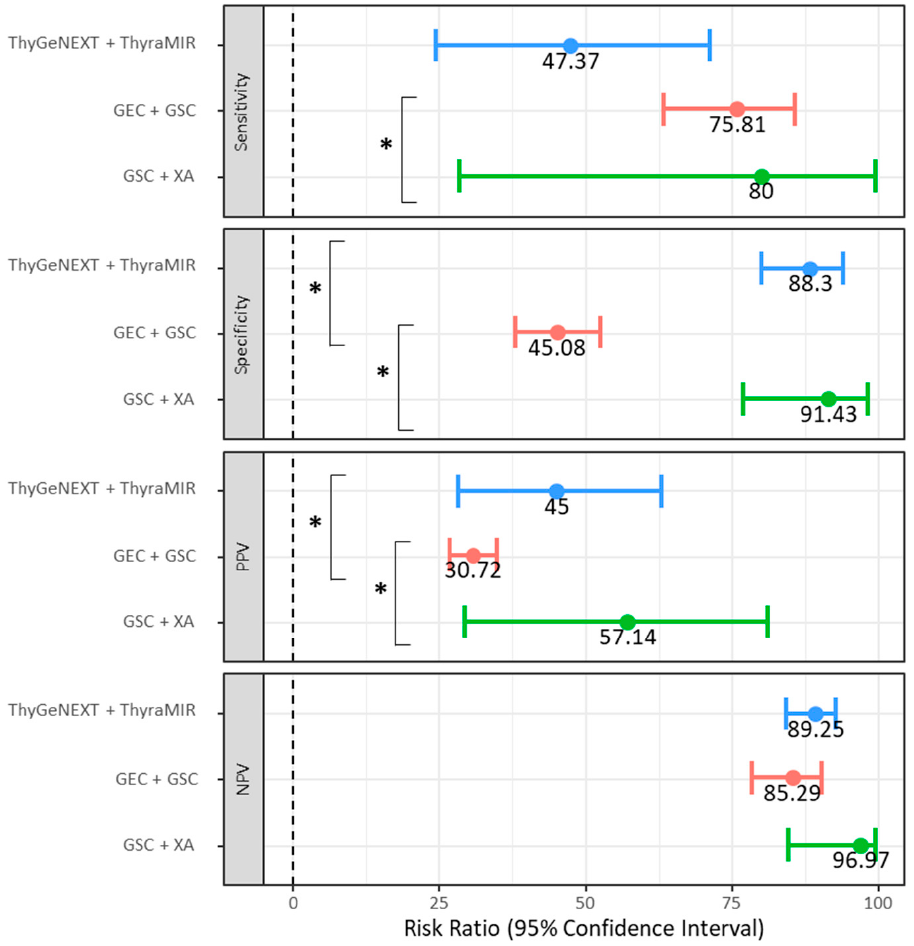
Figure 2. The sensitivity, specificity, positive predictive value, and negative predictive value in nodules undergoing the ThyGeNEXT + ThyraMIR, GEC + GSC, and GSC + XA molecular testing. PPV: positive predictive value; NPV: negative predictive value. * indicates p < 0.05.